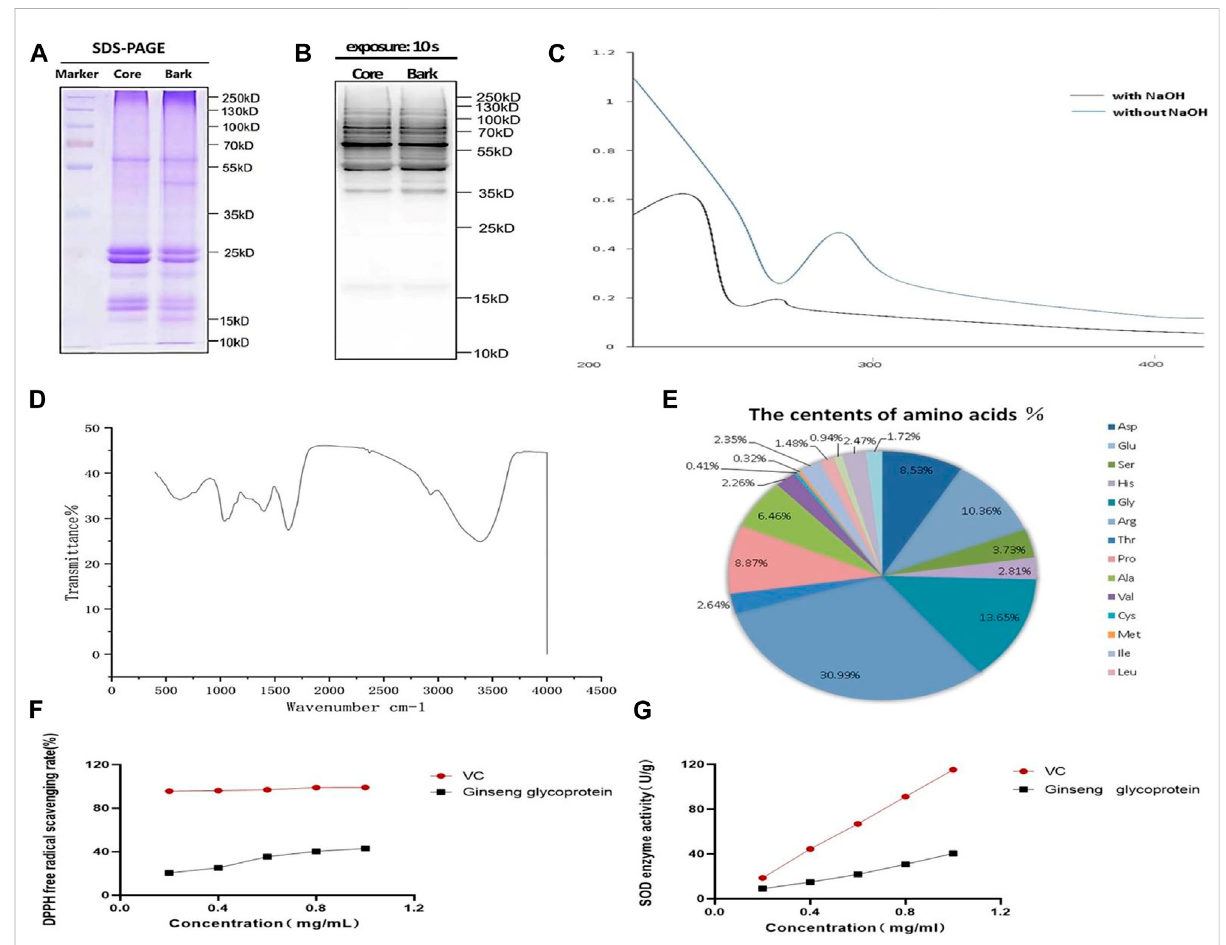
FIGURE 2 Structure and physicochemical properties of ginseng glycoproteins. (A) The results of Komas Brilliant Blue staining of ginseng extract samples; (B) ; Western blotting assay of anti-O-GlcNAc (C) UV spectra of ginseng glycoproteins; (D) Infrared spectra of ginseng glycoprotein; (E) Amino acid composition of ginseng glycoprotein; (F) Comparison of the DPPH radical scavenging rate of ginseng glycoprotein and VC; (G) Comparison of SOD expression of ginseng glycoprotein and